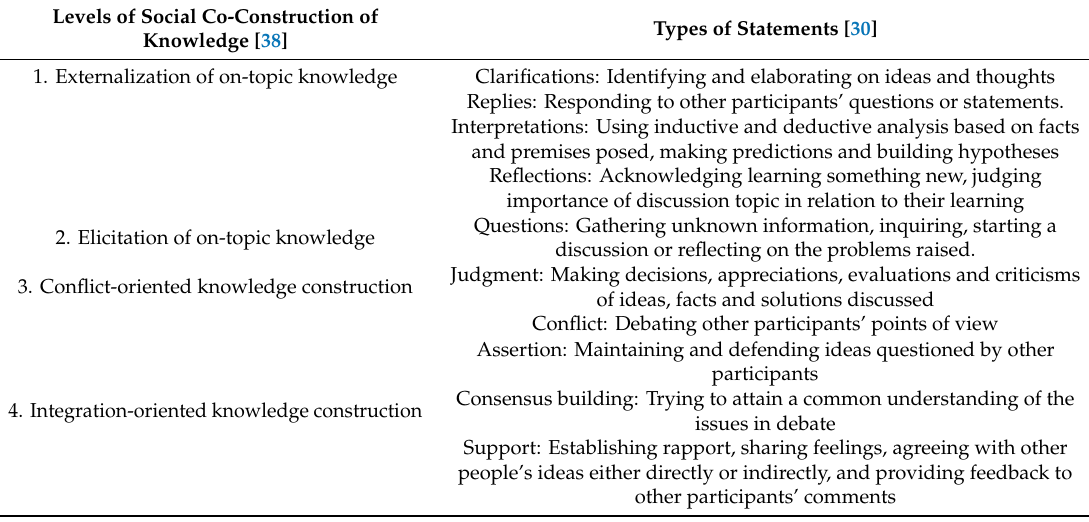
Table 1. Levels of social co-construction of knowledge linked to di ff erent types of statements used in